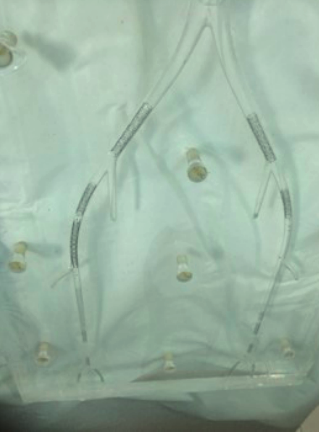
Figure 6. Photograph of the phantom with stents